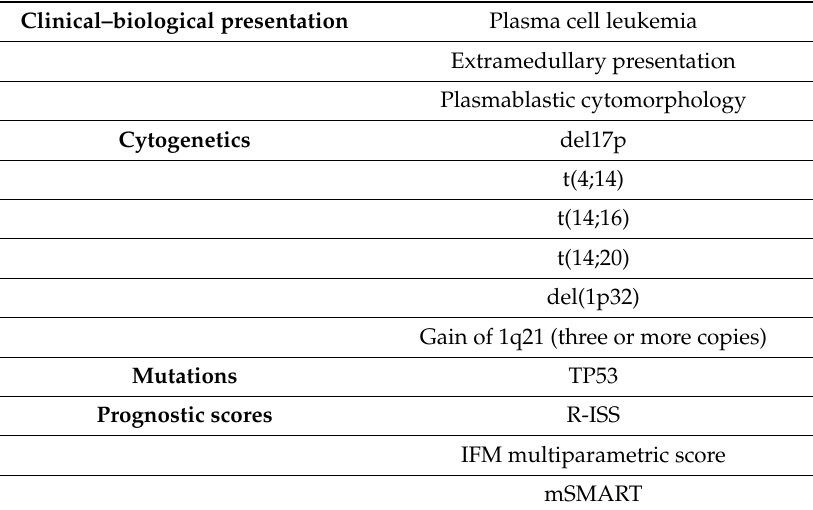
Table 1. Main characteristics used to define high-risk multiple myeloma in